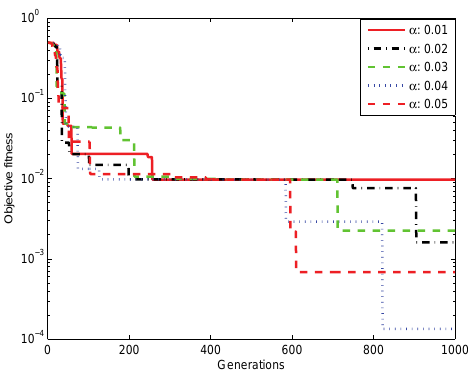
Figure 9: Objective fitness under di ff erent damping factors in the evolutionary